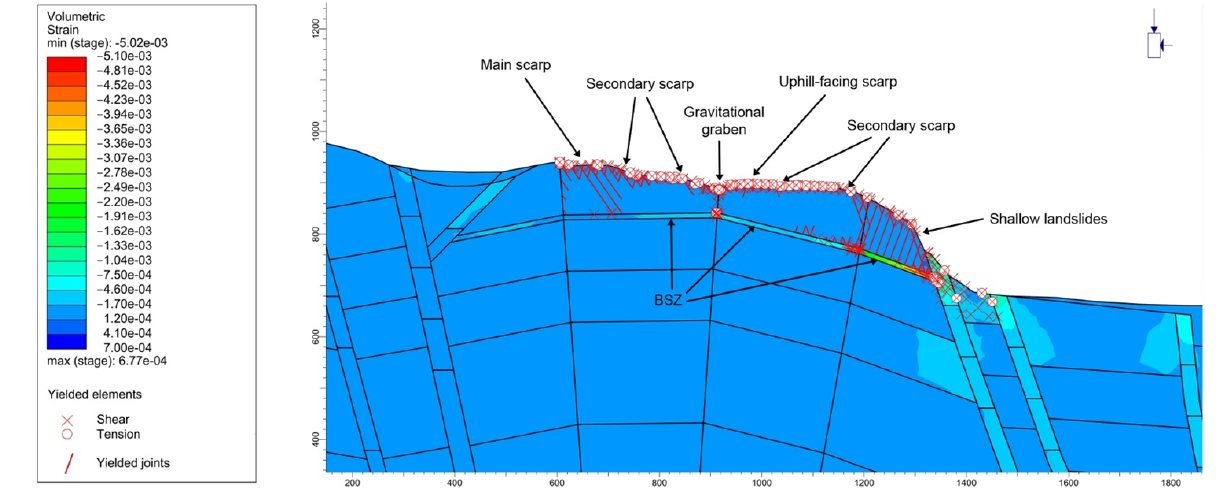
Figure 12. Numerical modeling results (volumetric strain and yielded nodes/joints) with indication of the main geomorphological features and kinematic elements constraining the DSGSD process. x -axis is in meters, while y -axis is in meters